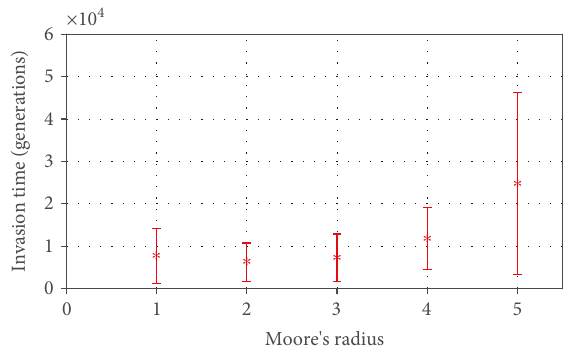
Figure 21: Relationship between invasion time of a silent cooperative gene and Moore ’ s neighborhood radius. Simulations are run for 100 times for each point with the vertical bars representing the standard